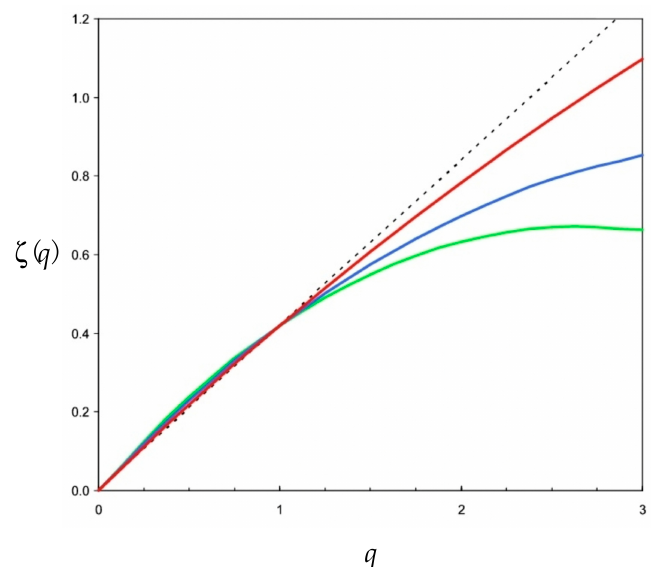
Figure 4. Illustration of the nonlinearity of the empirical function ζ ( q ) estimated for ammonium time series under different conditions of flows, i.e., 1 m s − 1 ( ε ~ 6 × 10 − 4 m 2 s − 3 , red), 0.5 m s − 1 ( ε ~ 7.5 × 10 − 5 m 2 s − 3 , blue), and 0.2 m s − 1 ( ε ~ 4.8 × 10 − 6 m 2 s − 3 , green) in comparison to the theoretical linear non-intermittent case ζ ( q ) = qH (black dotted line). Note that the empirical function ζ ( q ) are consistently non-linear and convex, with an increasing divergence to the theoretical linear case ζ ( q ) = qH , with increasing values of the statistical order of moment q . The dissipation rate of turbulent energy ε (m 2 s − 3 ) were estimated from the velocity of the tidal flow v as ε = φ v 3 / z , where z is the depth of the water column ( z ~ 10 m) and φ is a constant, φ = 0.006; see Equation (15) below.